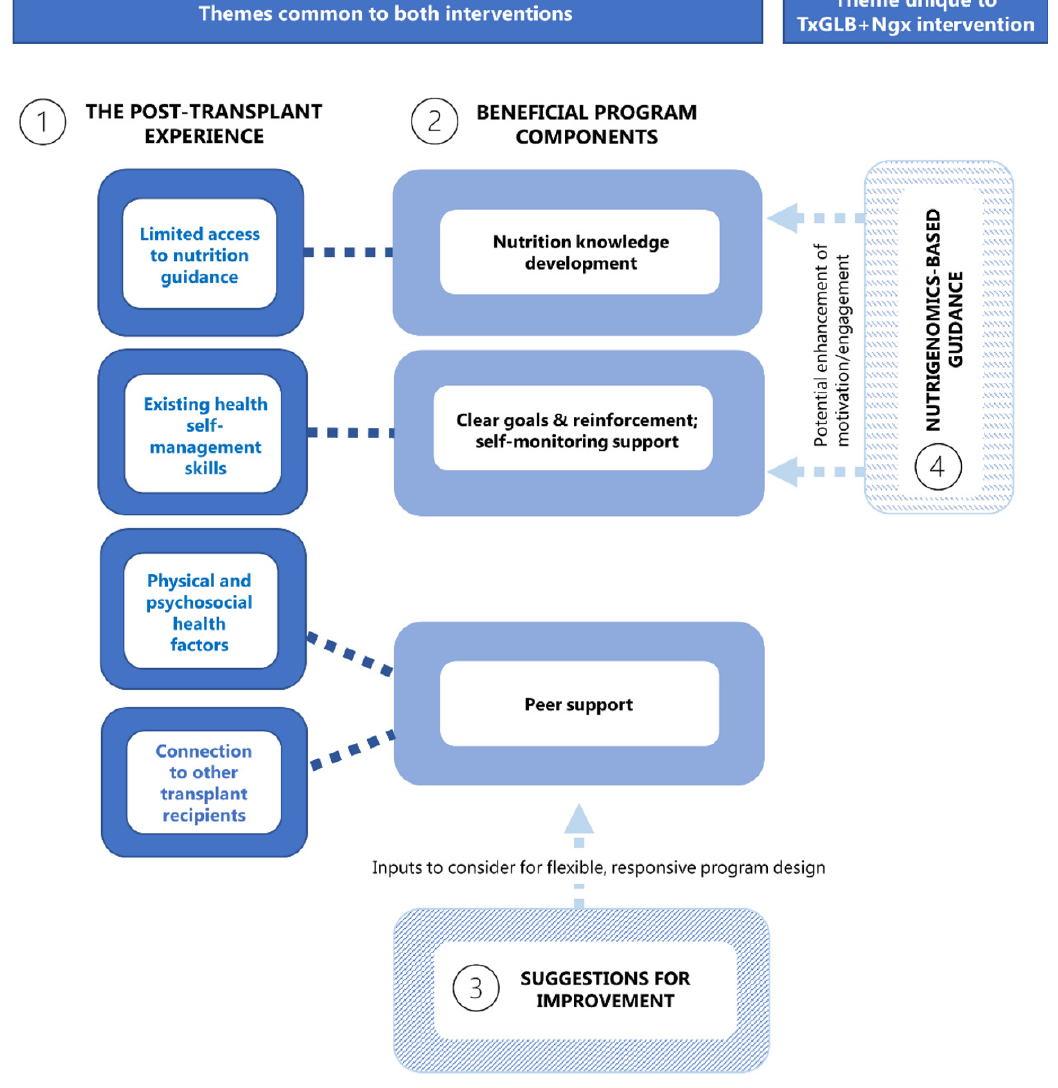
Figure 1. Interrelationships between themes and sub-themes for both intervention groups (Tx-GLB and Tx-GLB + Ngx). The behavioural components of the modified GLB program (subtheme 2B) were also identified as beneficial by participants, who described having extensive experience